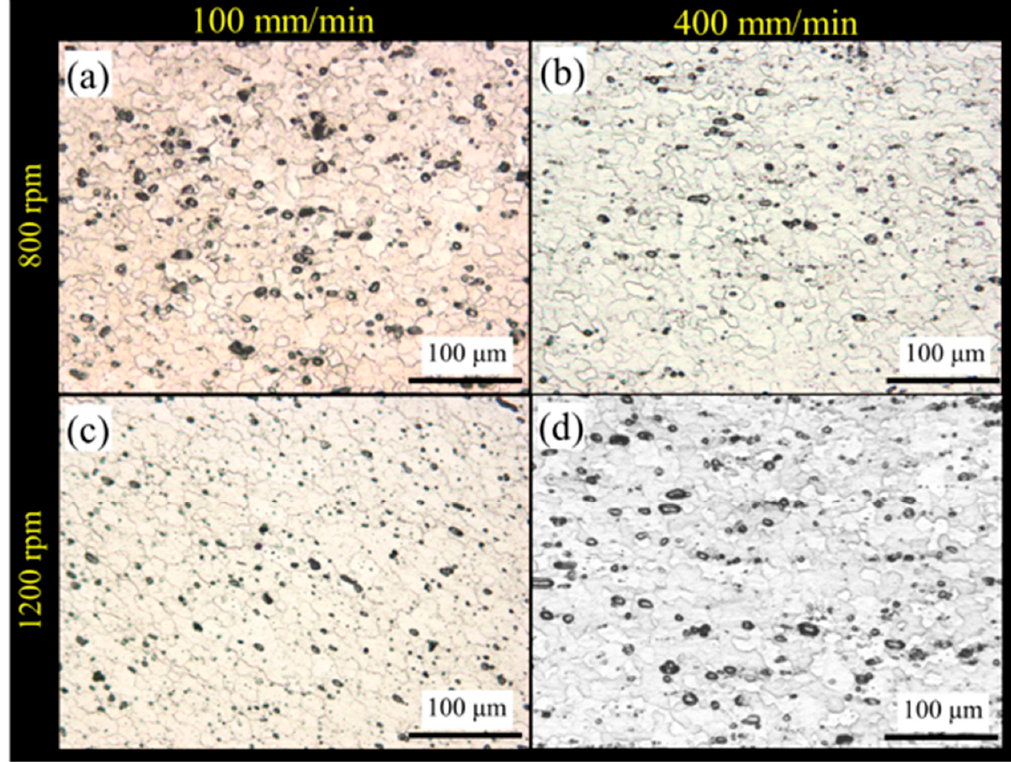
Figure 5. Microstructures of the SZs of similar joints for Al6061(T6): ( a ) Sample A-1, ( b ) Sample A-4, ( c ) Sample C-1, and ( d ) Sample C-4. ( c ) Sample C-1, and ( d ) Sample